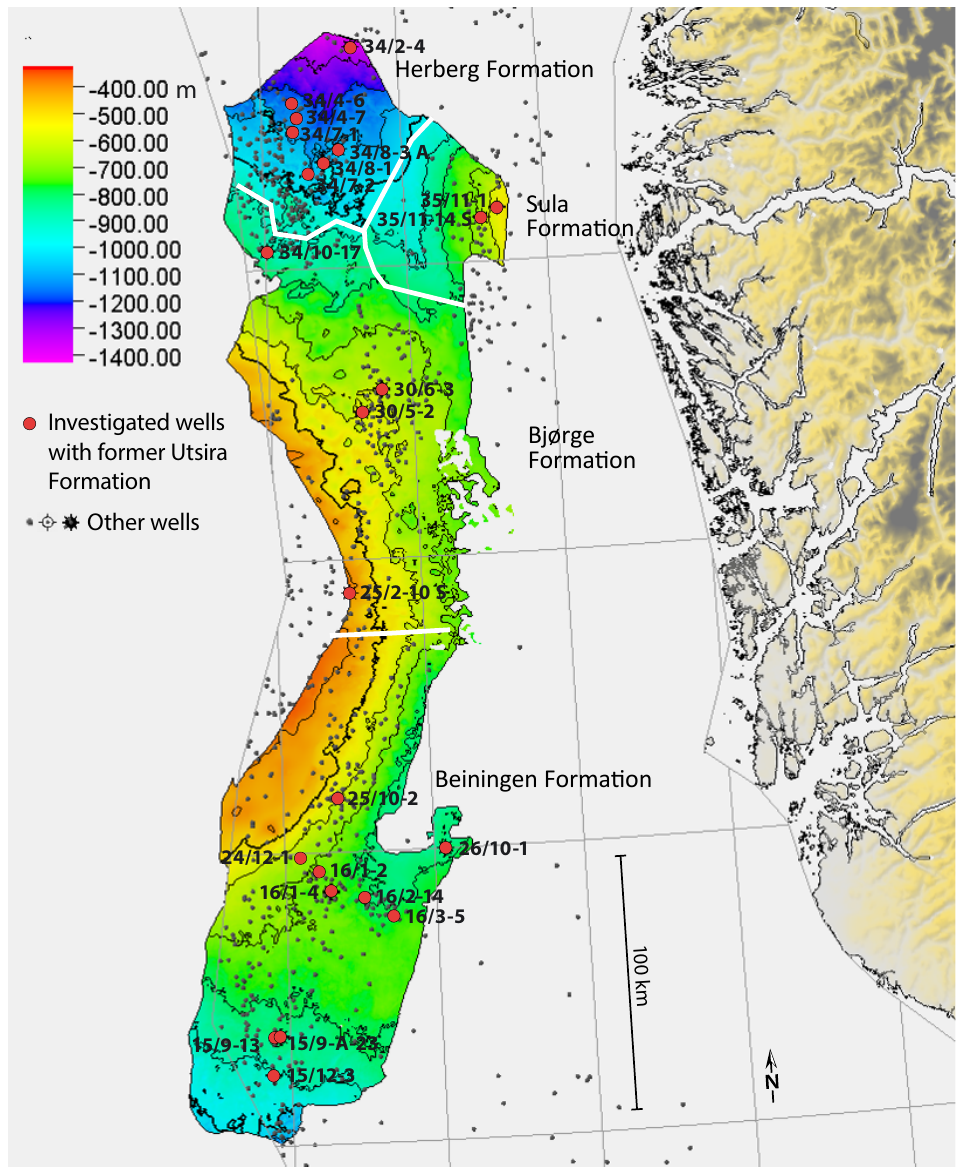
Figure 56. Map showing the extent of the Beiningen, Bjørge, Herberg and Sula formations (former Utsira Formation) of the Utsira and Nordland groups and the depth to the top of the formations